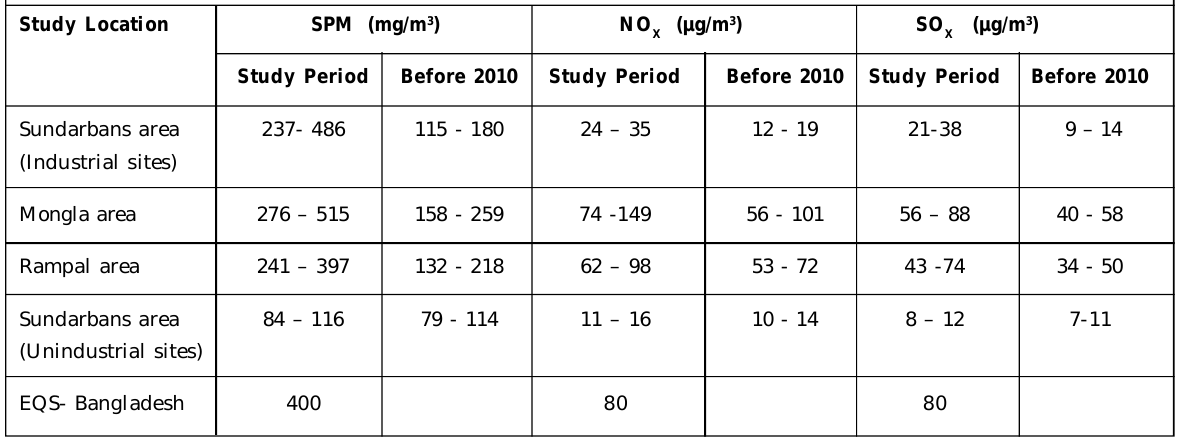
Table 3: Air quality of the study areas (Rampal, Mongla and the Sundarbans) Study